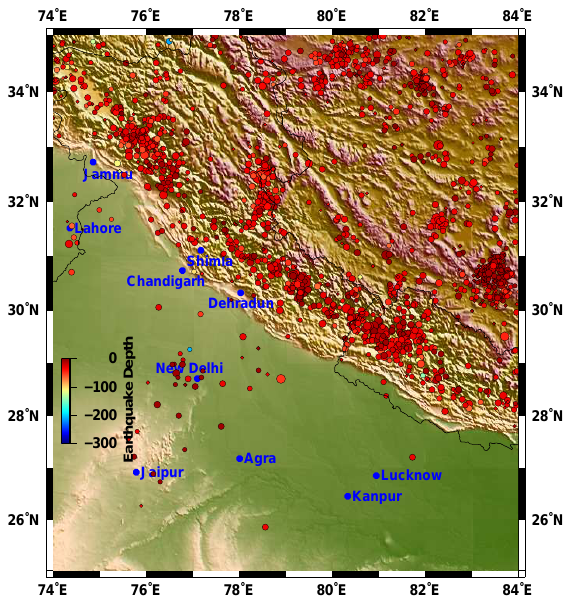
Figure 1. The selected region for Experiment 1 Wang et al., 2017). Detailed discussion of these two methods is provided